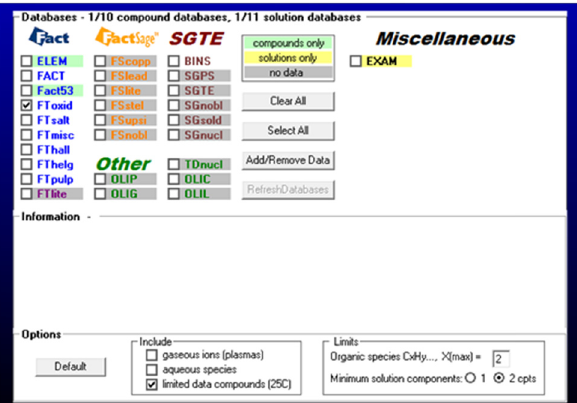
Figure A3: Calculation of the input of ash component in melting temperature.